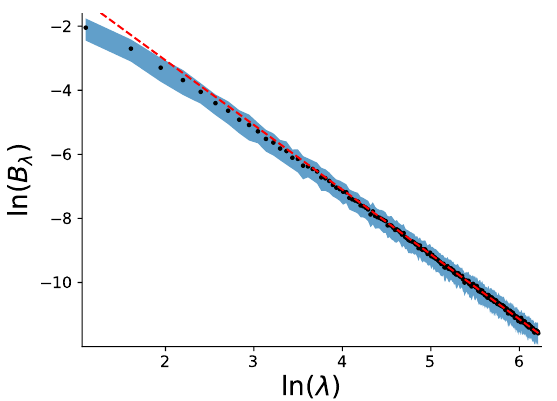
Figure 5 . Log-log plot of the smeared magnetic field strength, B λ , vs. λ . The blue band shows the 1- σ spread of the individual Monte Carlo results. The dashed line shows the fit ln( B λ ) = ( − 2 . 02 ± 0 . 02) ln( λ ) + (0 . 98 ± 0 . 09)